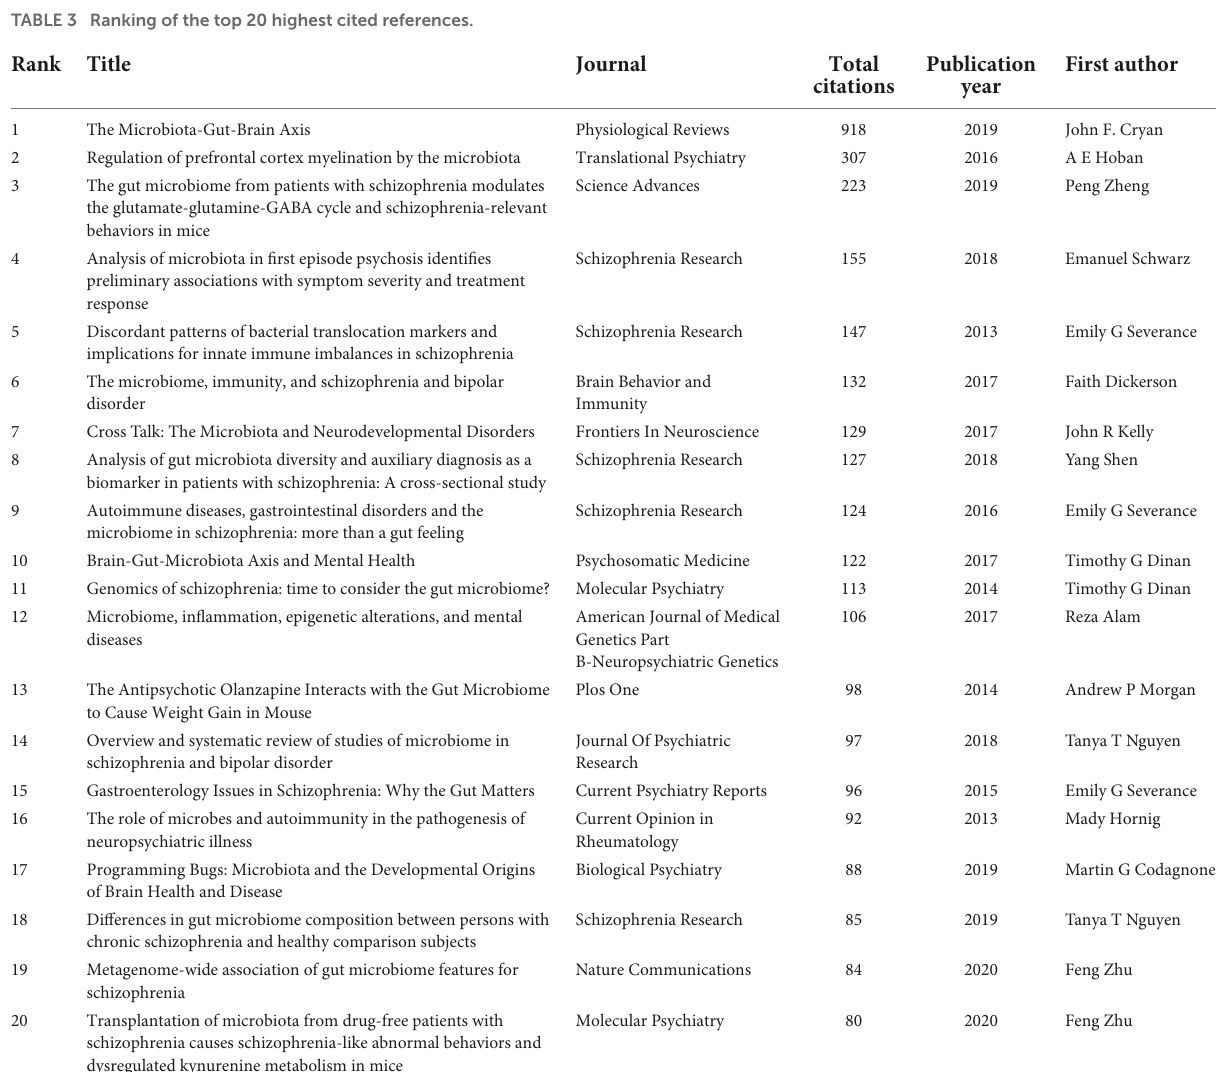
TABLE 3 Ranking of the top 20 highest cited references.